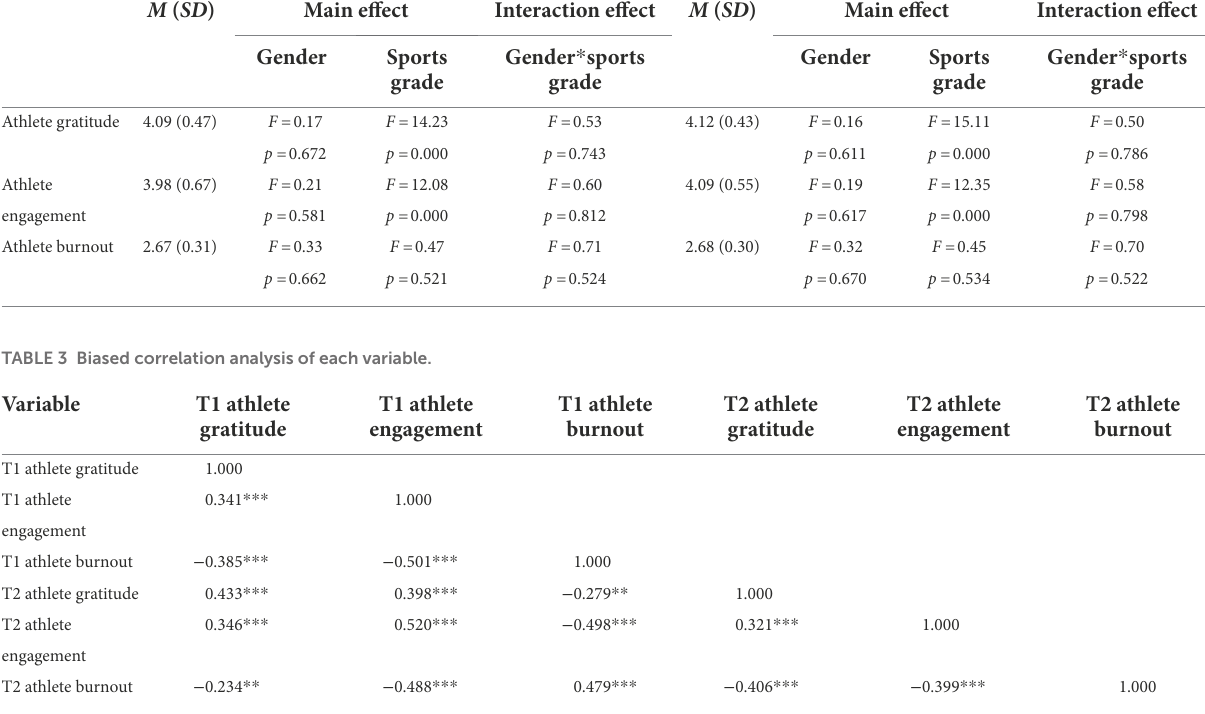
TABLE 2 Main effects and interaction effects of each variable in gender and sports grade. Variable